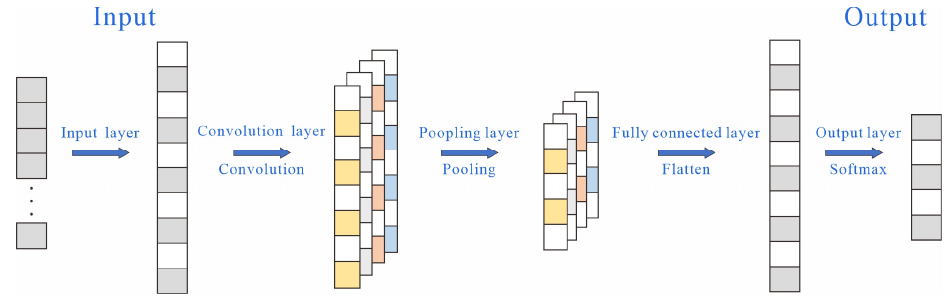
Figure 3. Structure diagram of 1D-CNN.